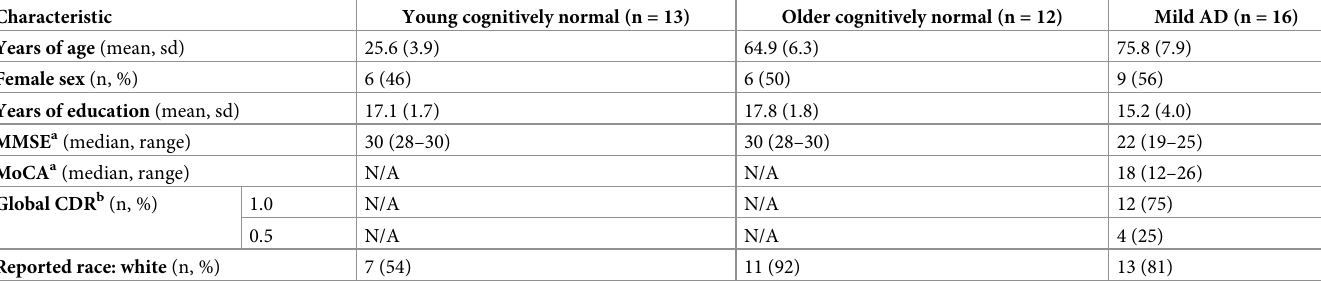
Percentages are rounded to the nearest integer. Abbreviations: AD, Alzheimer’s Disease; CDR, Clinical Dementia Rating; MMSE, Mini Mental State Examination; MoCA, Montreal Cognitive Assessment. a Ranges from 0 to 30, with a higher score indicating less impairment. b Ranges from 0 to 3, where 0 = normal, 0.5 = very mild dementia, 1 = mild dementia, 2 = moderate dementia, 3 = severe